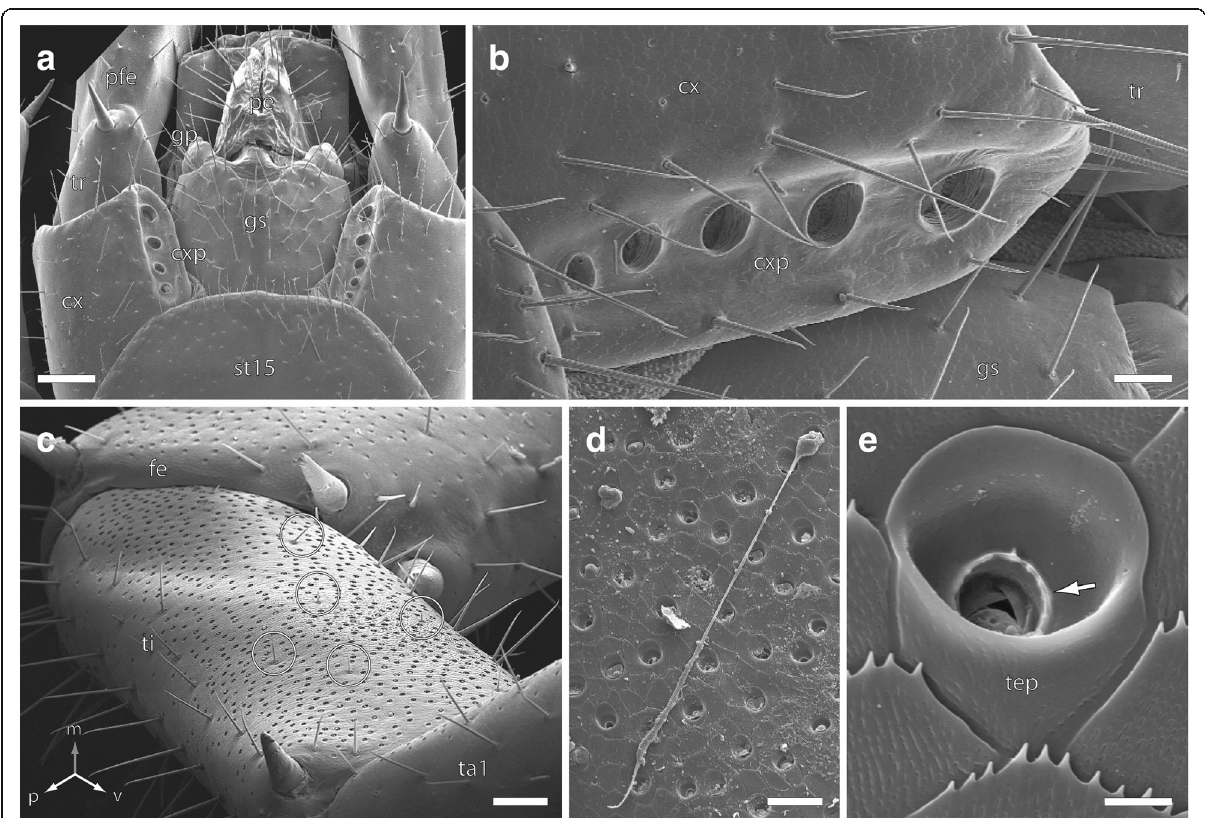
Fig. 3 Terminal trunk region of Lithobius forficatus . a Ventral view of male terminal trunk, ultimate leg coxae with coxal pores, and gonopods. Scale bar 200 μ m. b Close up on left ultimate leg coxa with coxal pores, ventral view. Scale bar 40 μ m. c Medial face of ultimate leg femur, tibia, and tarsus 1. Note the higher abundance of telopodal gland pores on the tibia. Except for s. mesotrichodea II (circles), the medial faces are devoid of sensilla. Scale bar 300 μ m. d Closely aggregated pores of telopodal glands on the tibia with secretion. Scale bar 20 μ m. e Detail of a telopodal gland pore. Note the dentate collar at the bottom of the pit, through which the glandular duct opens (arrow). Scale bar 3 μ m. Abbreviations: cx coxa, cxp coxal pores, fe femur, gp gonopods, gs sternite of gonopodial segment, pe penis, st sternite, ta tarsus, tep telopodal gland pores, ti tibia, tr